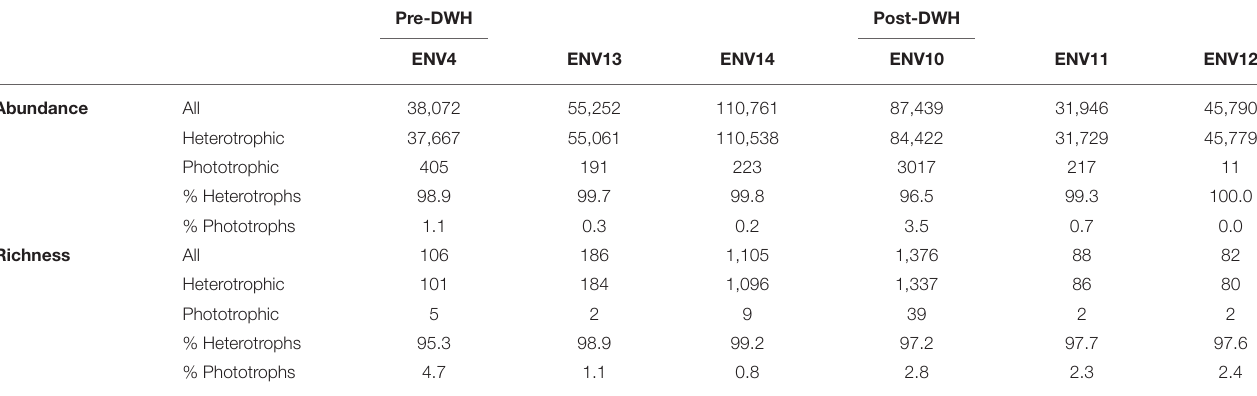
TABLE 1 | Heterotrophic and phototrophic abundance (OTUs read counts) and richness (OTU